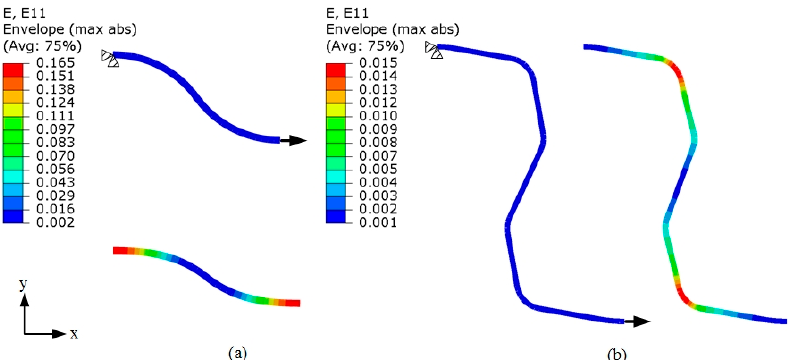
Figure 7. Strain distributions in ( a ) unit A and ( b ) unit B subjected to the same deformation to a displacement of 0.1 mm. max abs: maximum principal.